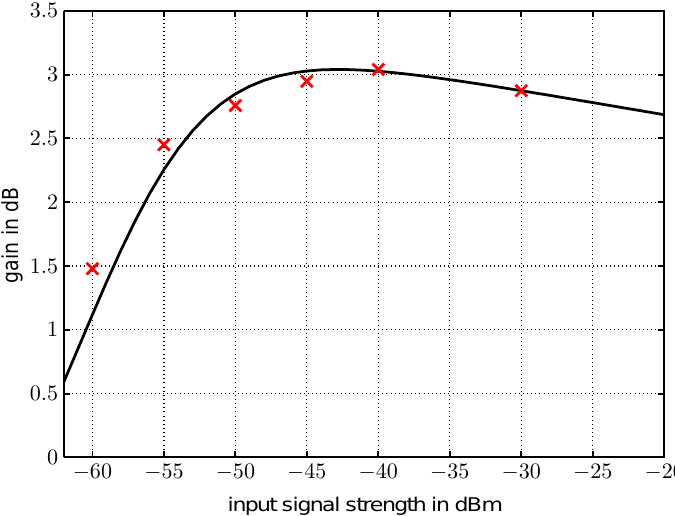
Figure 11. Experimentally measured gain in dB of the two antenna diversity